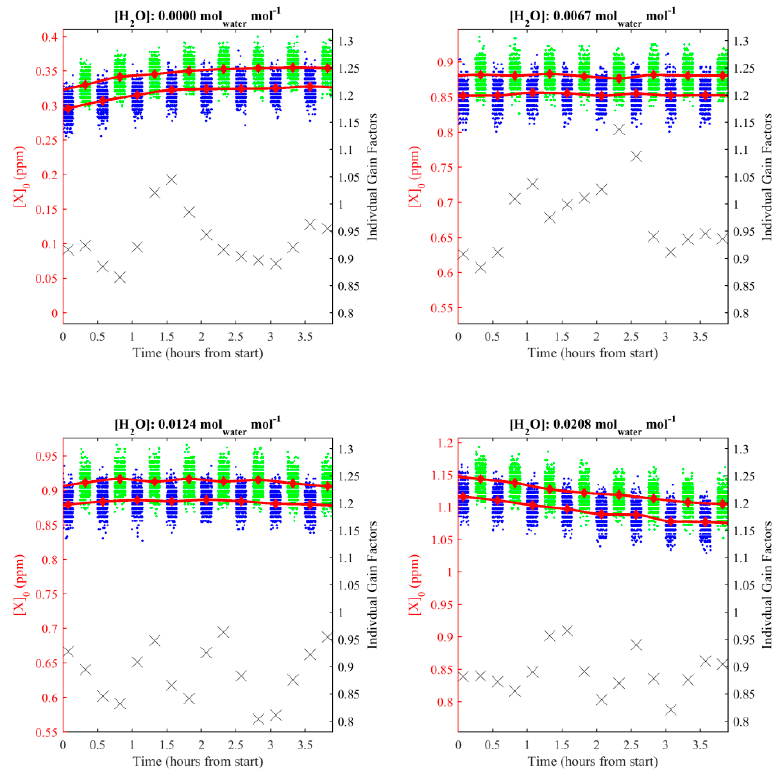
Figure 3. [ X ] 0 measurements recorded during [ X ] h sampling (blue dots) and [ X ] l sampling (green dots) for each humidity setting, plotted against the left-hand axis. Unstable measurements after each gas transition were discarded and are not shown. Averaged [ X ] 0 l and [ X ] 0 h values are plotted as red diamonds against the left-hand axis. [ X ] 0 l and [ X ] 0 h interpolation curves are plotted as red lines. Individual calculated gain factors (black crosses) corresponding to each [ X ] 0 l and [ X ] 0 h pair are plotted against the right-hand axis.